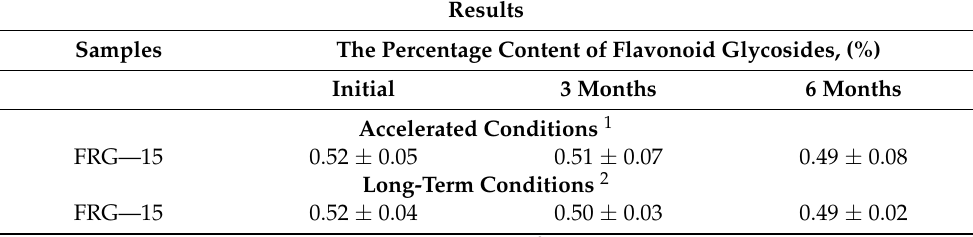
Table 4. The FRG—15 formulation’s (the film formulation contained 0.4 g of GFD, 0.3 g of glycerol and 2 g of 2% CMC) active compound stability studies were performed during 6 months storage under accelerated and long-term conditions, ( n = 3).